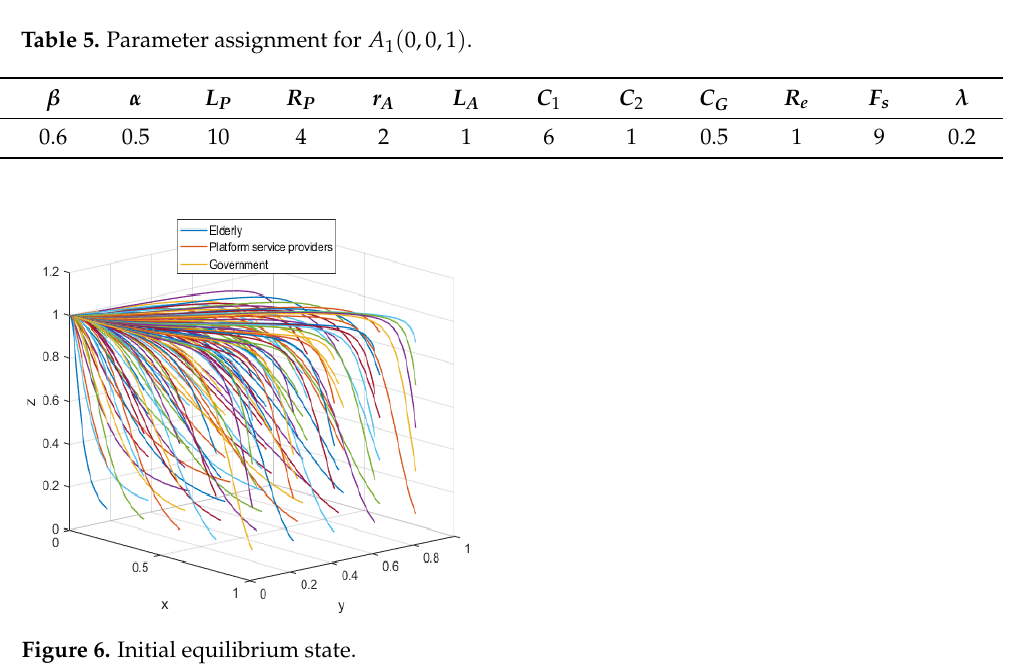
Figure 5. Ideal equilibrium state.